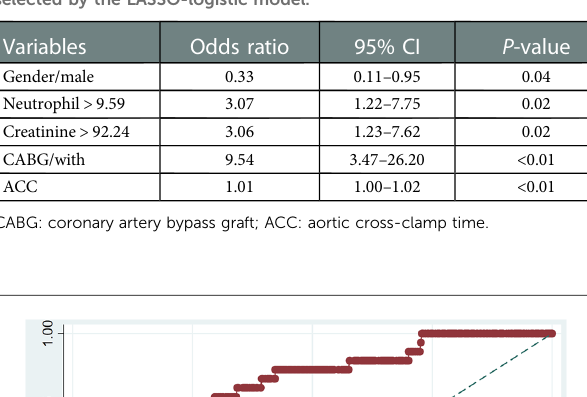
FIGURE 6 Decision curve analysis of the